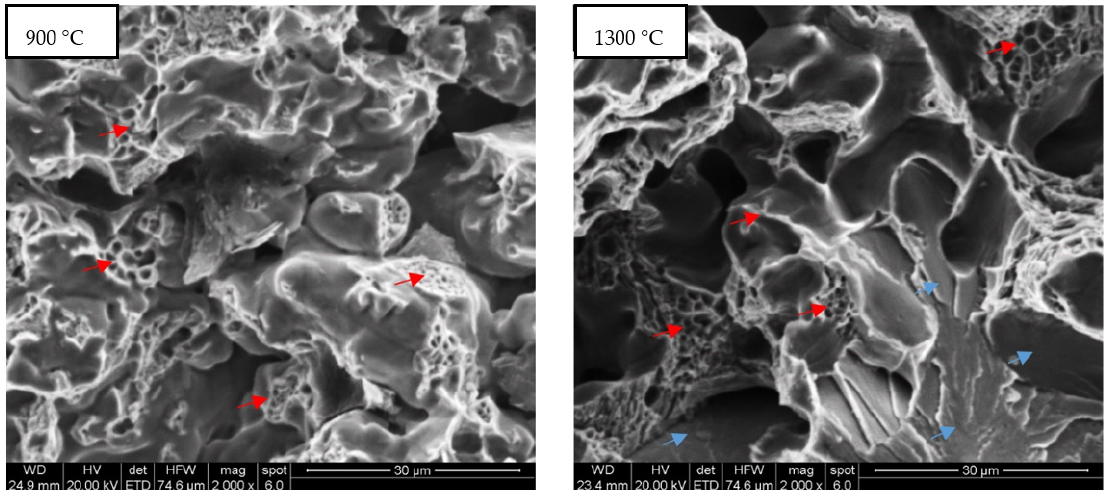
Figure 4. Dimple ductile (red arrows) and transgranular cleavage facets (blue arrows) in fractographs of Fe-0.8C, sintered at different temperatures, broken by Charpy impact at RT, 2000×.